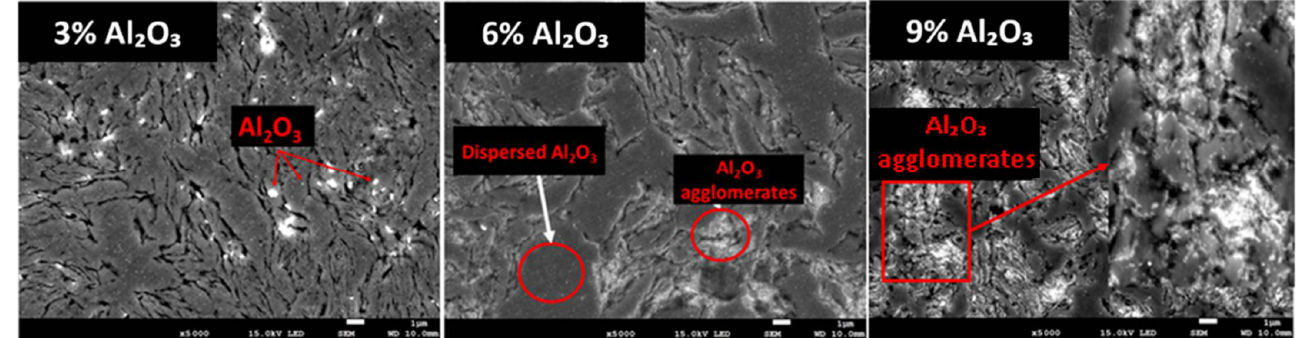
Figure 6. SEM of Cu/Al 2 O 3 nanocomposite with Al 2 O 3 percentage of 3, 6, and 9%.